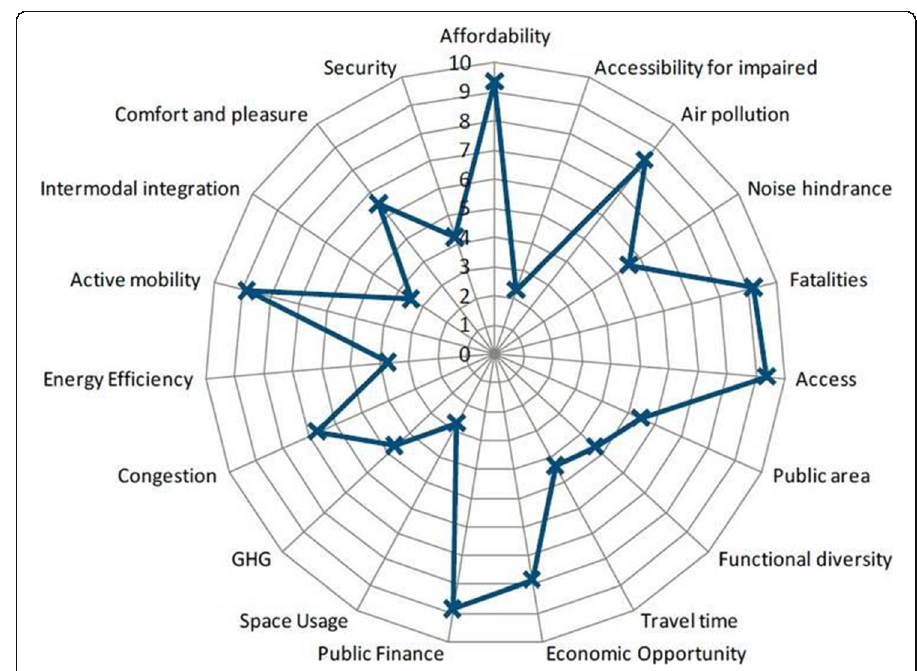
Fig. 1 The 19 Sustainable Urban Mobility Indicators used by the World Business Council for Sustainable Development (WBCSD) for assessing sustainable mobility measures